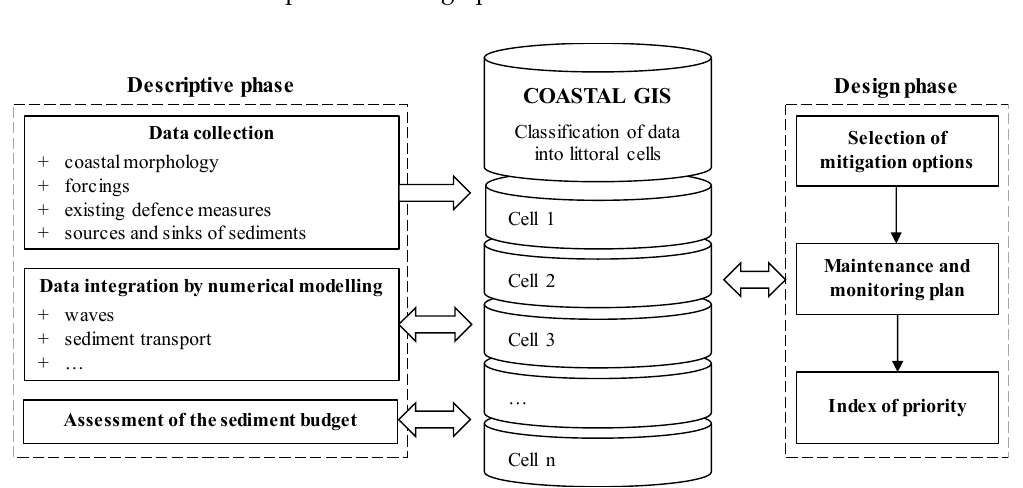
Figure 1. Breakdown of coastal plan activities. The Coastal GIS includes both data (measured or computed) gathered in the descriptive phase and the results following the design phase.